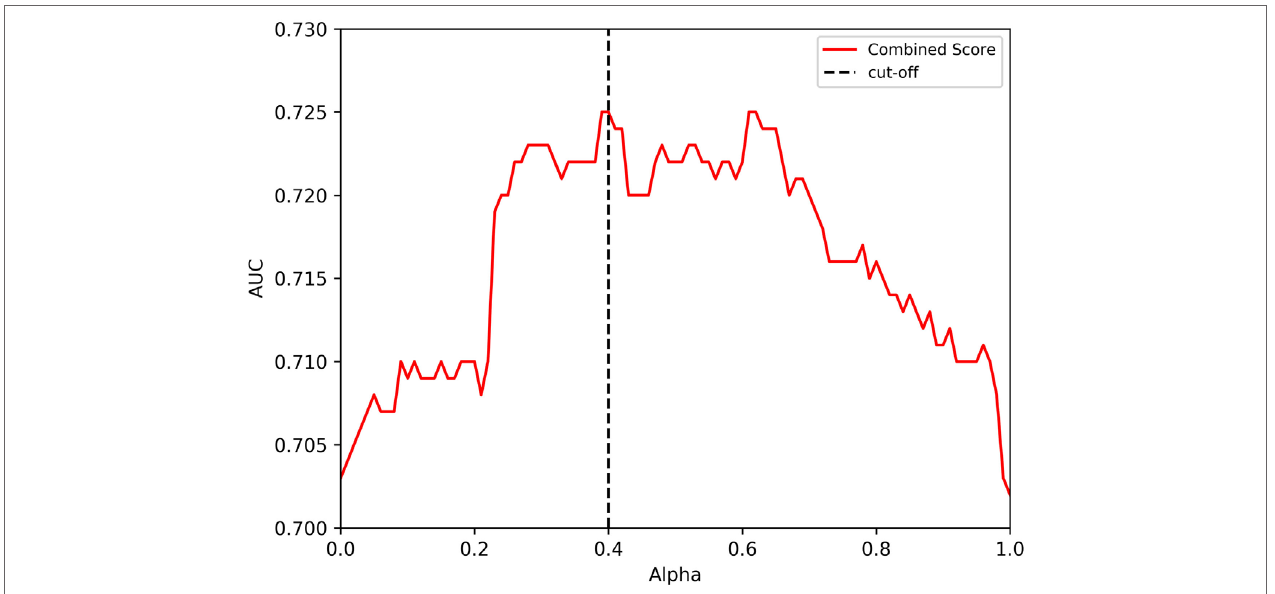
FigUre 3 | Performance of independent literature datasets with combined approach and varying degree of alpha on the model trained with initial, in-house and tetramer datasets. The prediction values from HLA score and immunogencity score using different values of alpha are shown. A cutoff of 0.4 value for alpha is also highlighted by a dotted